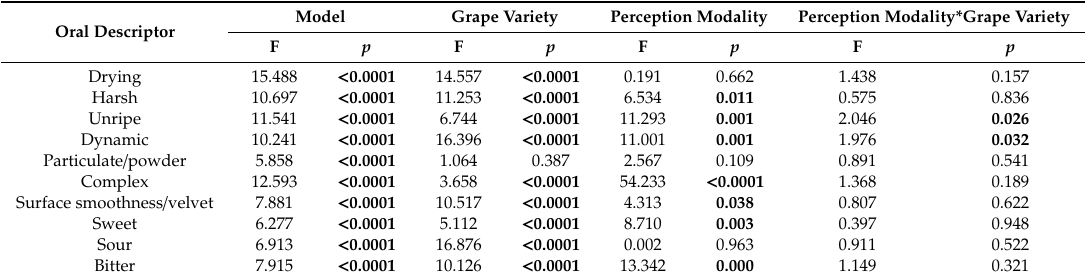
Table 2. Three-way ANOVA (judges as random factor, grape variety and perception modality as fixed factors) computed to test the discrimination e ff ect of in-mouth descriptors and to evaluate the impact of the perception modality (with and without odours, WWs and DWs, respectively) on oral sensory perception of the 74 red wines investigated.